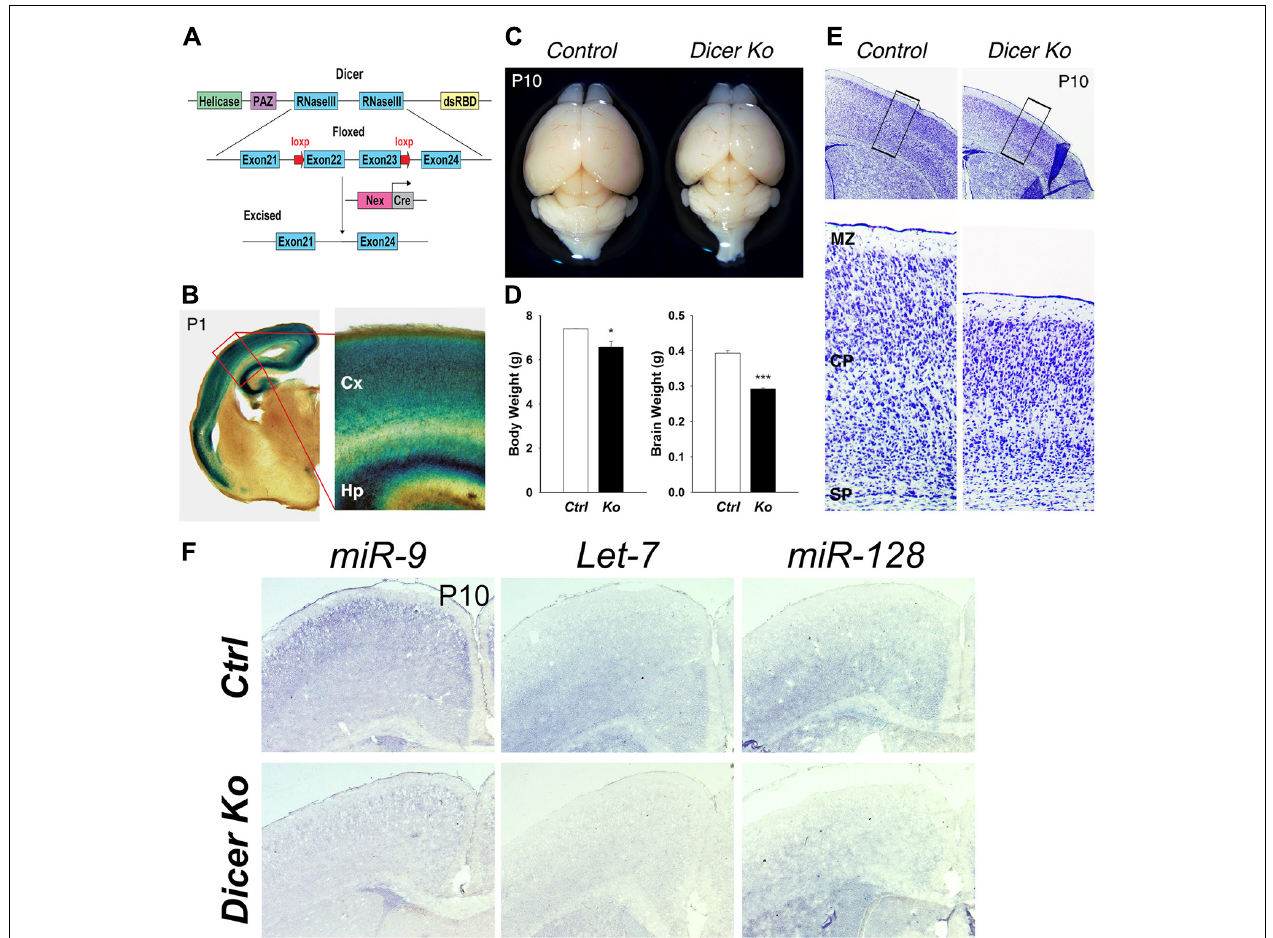
FIGURE 1 | Conditional ablation of Dicer in postmitotic neurons of the cerebral cortex results in a smaller cortex and reduced thickness ofthecorticalwall. (A) Dicertargetingconstruct.TheN-terminalRNAhelicase domain, piwi argonaute and zwille (PAZ) domain, two ribonuclease III domains, and a double-stranded RNA- binding domain (RBD) are labeled.The exon 22 and exon 23 of Dicer are conditionally excised after Nex-Cre recombination. (B) X-gal staining at the level of the cortex in a Nex-Cre and Rosa26-LacZ - expressing mouse at P1 illustrating cortical specificity of the Nex-Cre line.The red box indicates the region shown at higher magnification.The cortex (Cx)